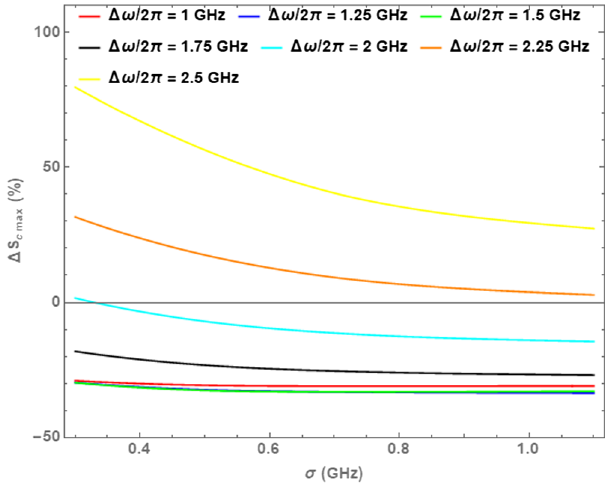
FIG. 19. The percentage variation of the maximum modified Poynting vector over the structure from the breakdown limit described by Eq. (19). A positive value signifies that S exceeds the limit and a negative value is within the limit. Δ S is given for a range of Δ ω where L ¼ 0 . 5 m and h G i ¼ 80 MV = m for this